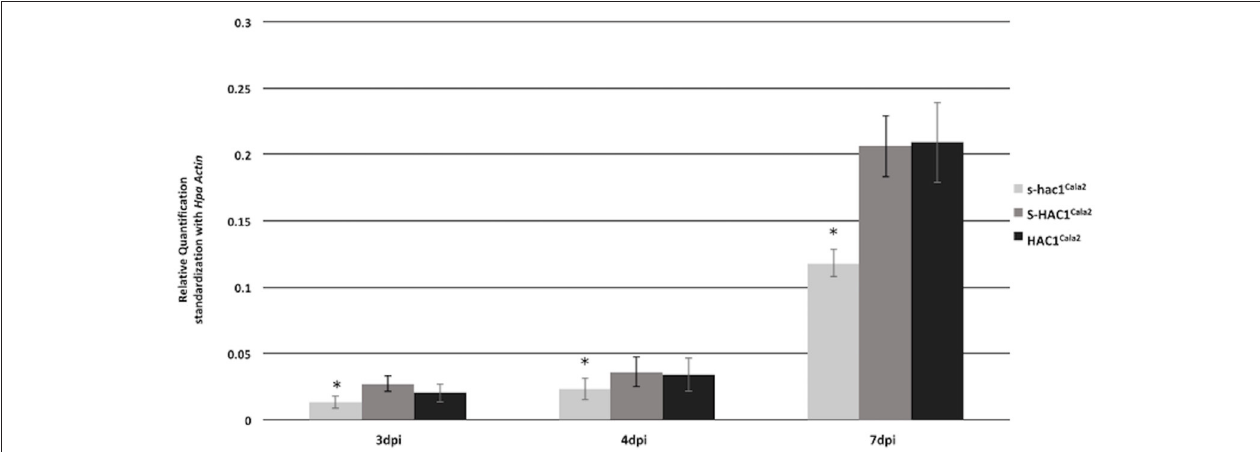
FIGURE 7 | Expression analysis of s-hac1 Cala2 , S-HAC1 Cala2 and HAC1 Cala2 . Total RNA was isolated from infected Hpa -Cala2 at 3, 4 and 7dpi. Quantitative Real-time PCR was carried out using gene specific primers for HAC1 Cala2 , S-HAC1 Cala2 and s-hac1 Cala2 . Fifteen seedlings from each genotype made up a sample and three replicates were used for each sample, the experiments were repeated three times with similar results. Expression level of s-hac1 Cala2 was significantly lower than that of S-HAC1 Cala2 and HAC1 Cala2 in Hpa -Cala2 background. Asterisks denote statistical significance in two-tailed Student’s t -test ( p < 0.05).